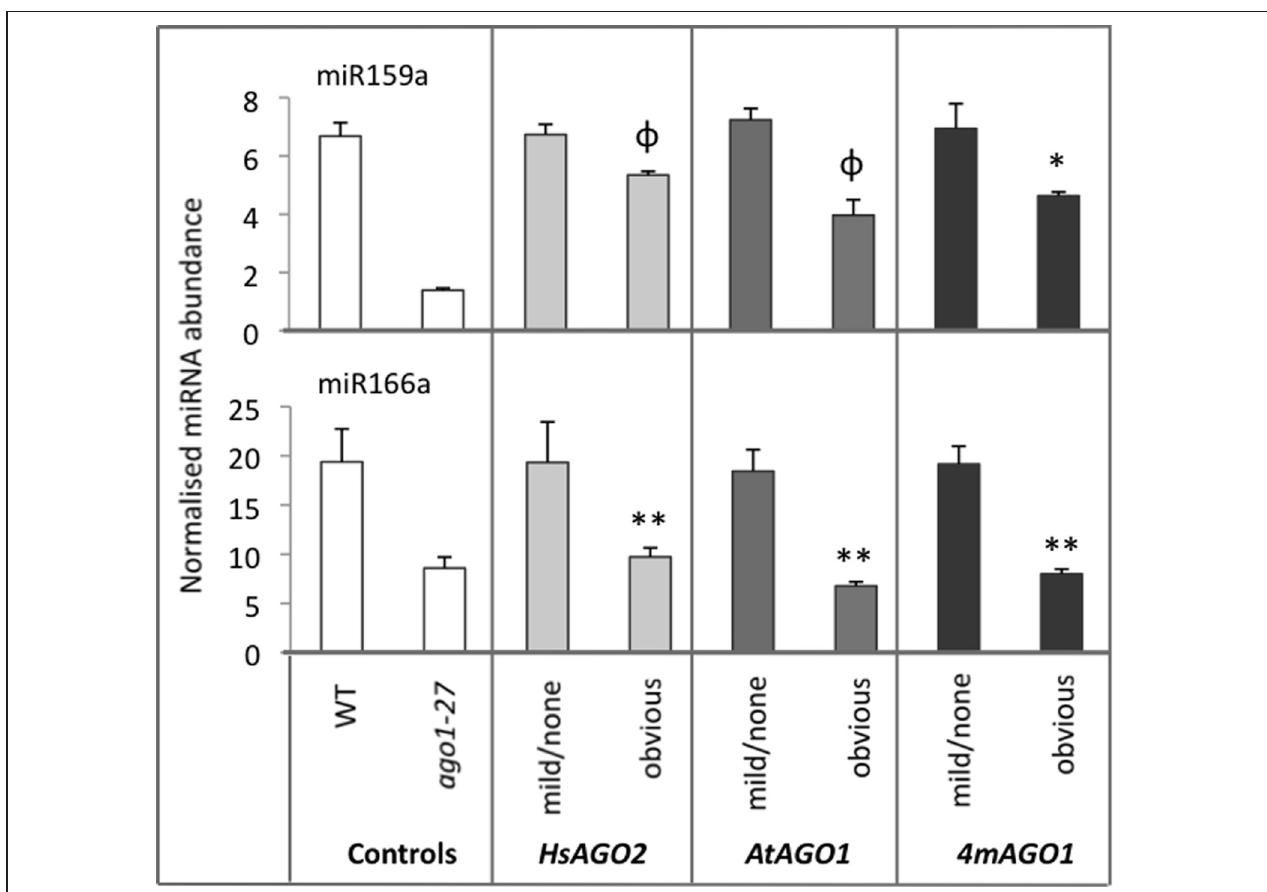
FIGURE 3 | miRNA abundances decrease in AGO overexpressing plants. The abundances of miR159a and miR166 were measured in total RNA from sample pools composed of 4–8 transformants, 24-days old, from each morphological category for each construct. Wild type (WT) and ago1–27 plants, grown in parallel, were included as controls. miRNA levels are normalized to the small RNA sno101. Data is averaged from two technical